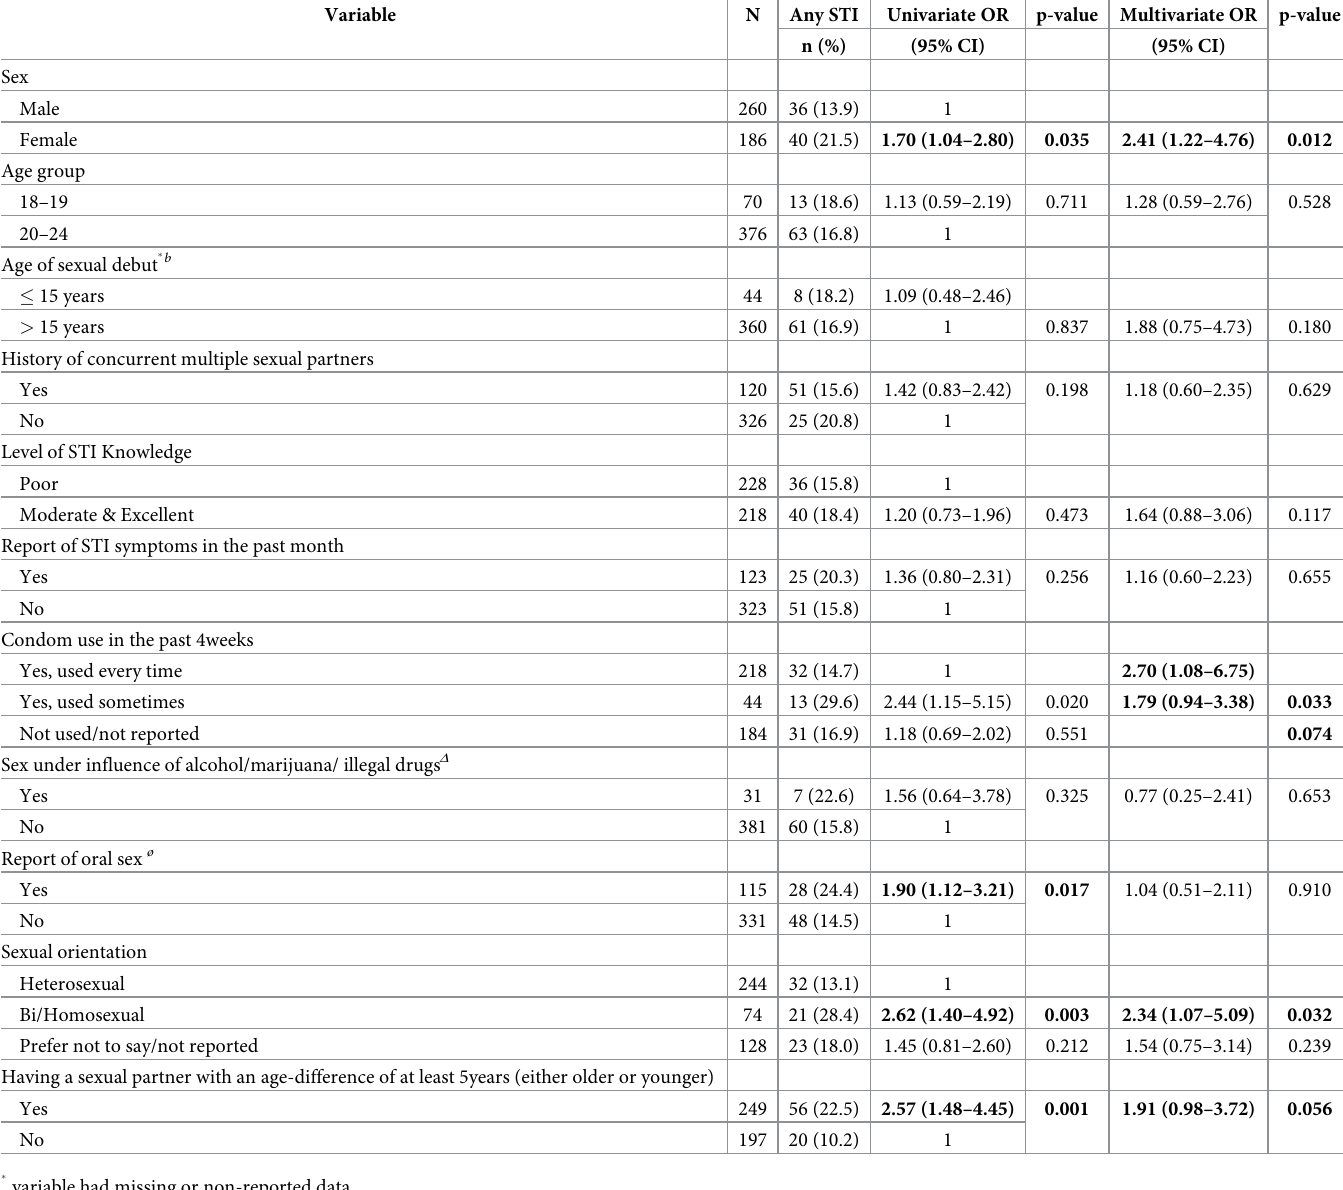
Table 3. Factors associated with presence of an STI among participants (N =